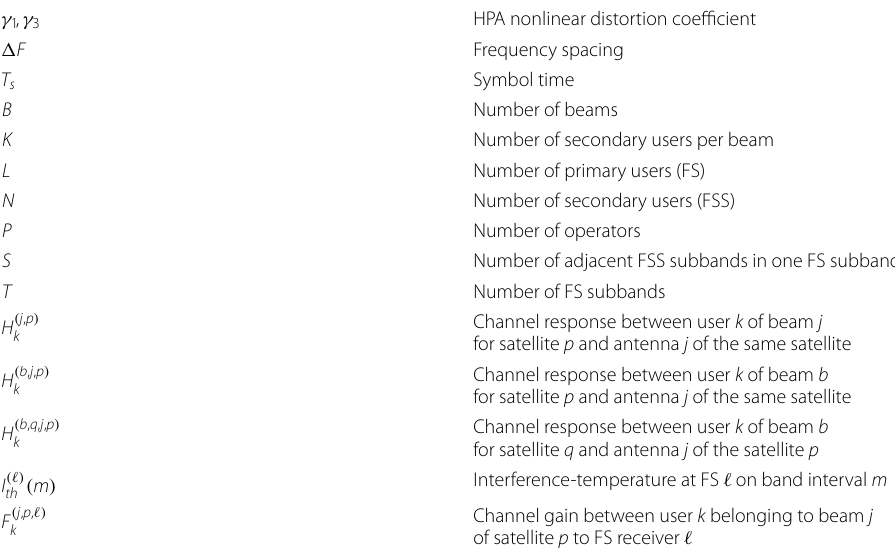
Table 1 List of symbols γ 1 , γ